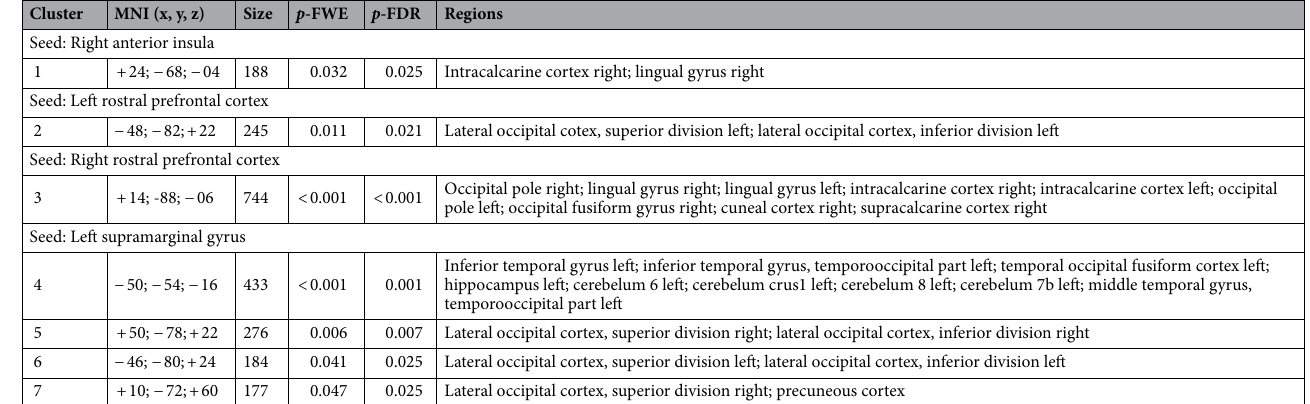
Table 3. Clusters of voxels functionally connected with nodes of salience network, correlating with mother´s education. FWE: family-wise error; FDR: false discovery rate; MNI: Montreal Neurological